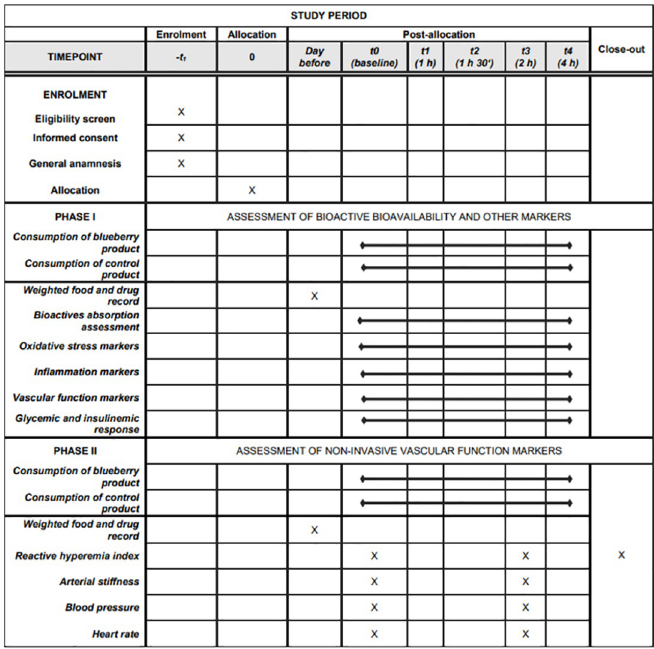
Fig 1. Schedule of enrollment, interventions, and assessment: Recommendations for interventional trials (SPIRIT).